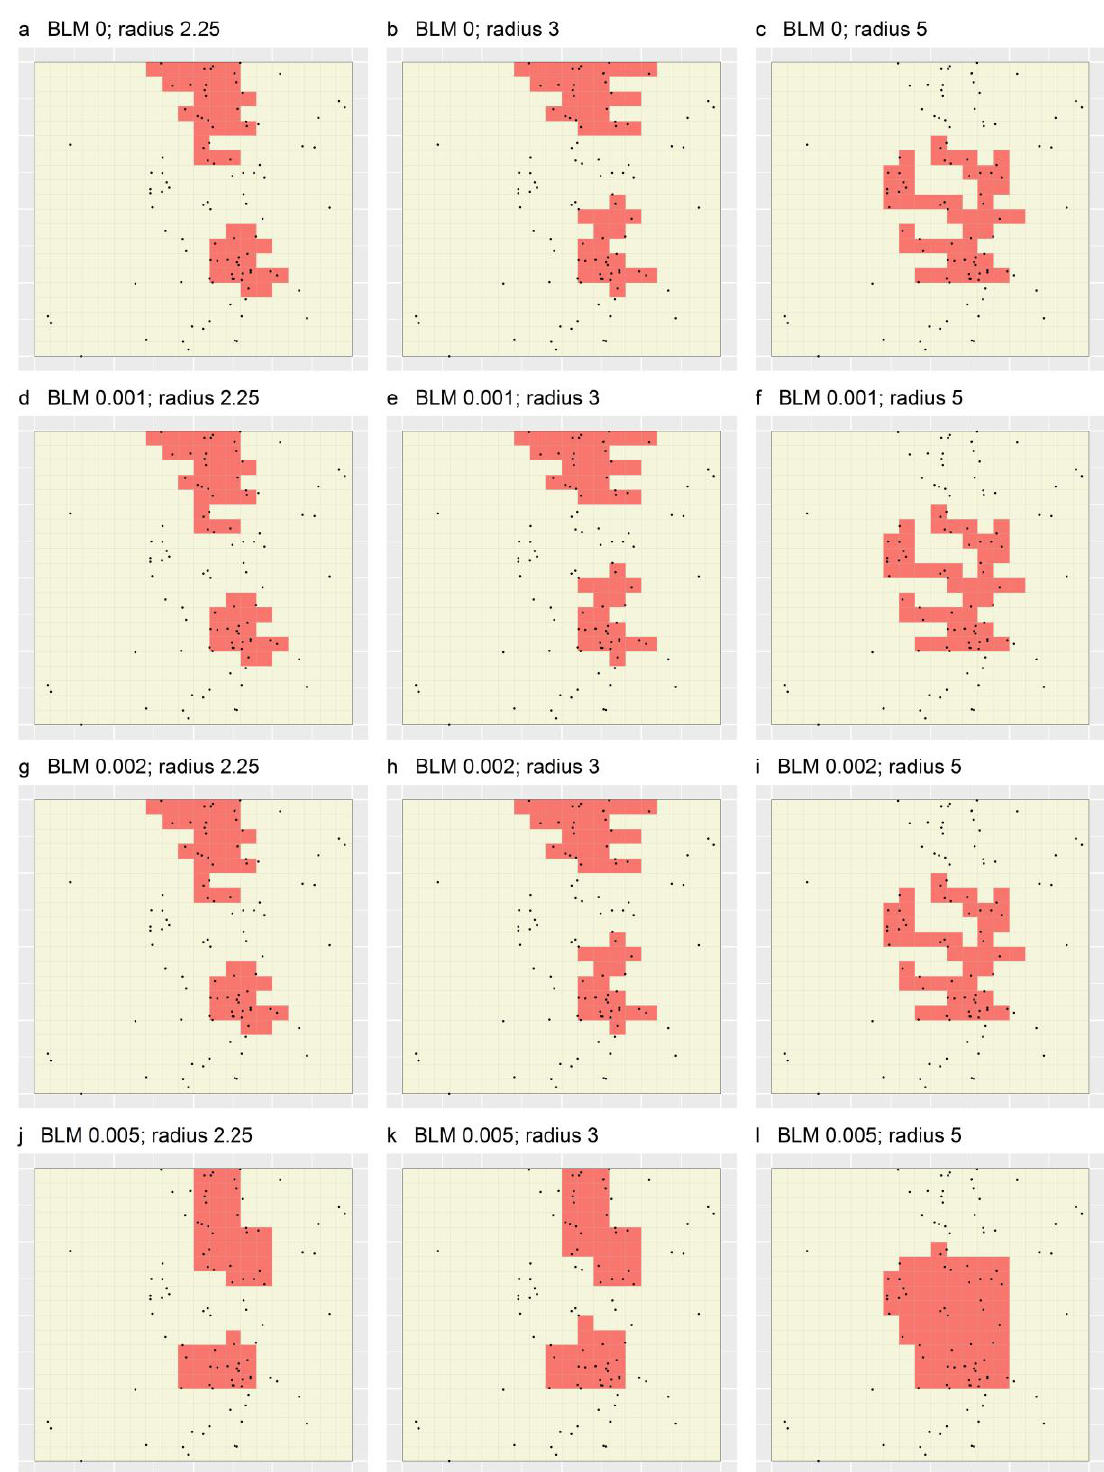
Figure 7. Optimal portfolios produced through applying Marxan + MinPatch to a simulated dataset based on 12 combinations of BLM and radius, and simulated whittling. Black dots depict the locations of simulated cases, and grid lines represent the set of spatial planning units. In each panel, shaded regions comprise ≥ 50% of